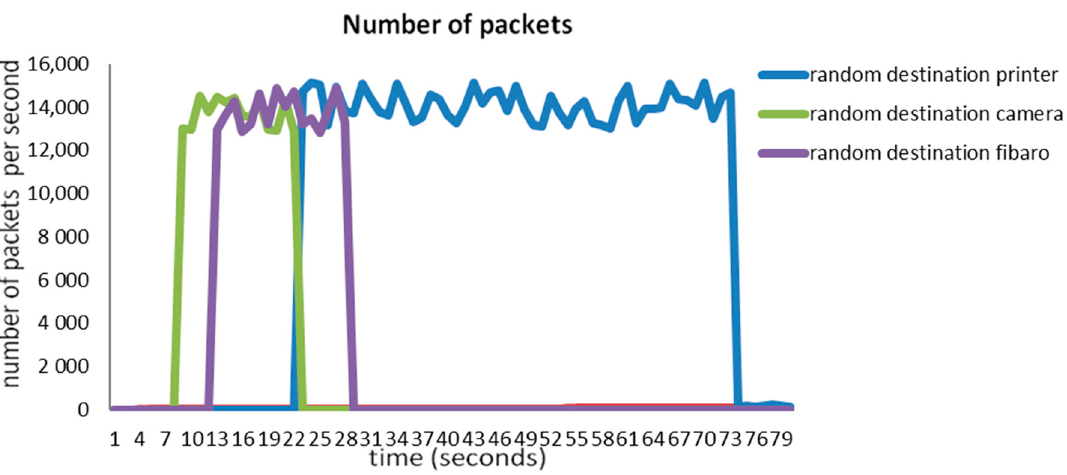
Scheme 5. Scenario 5 — communication timeline.